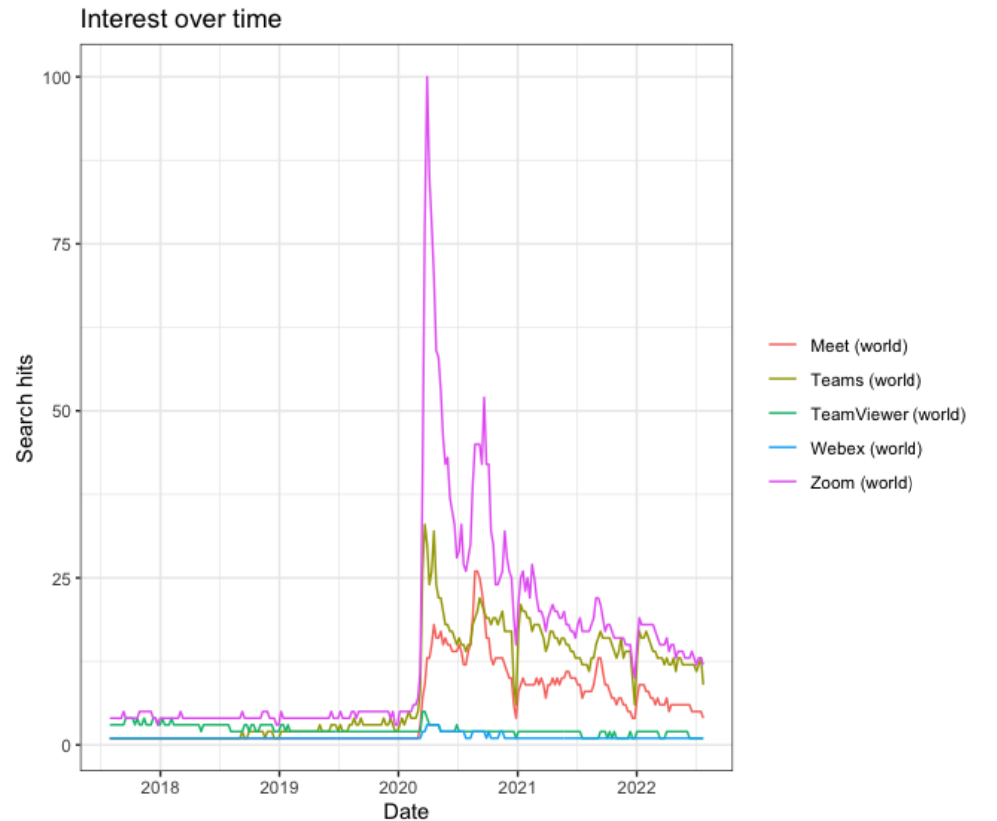
Figure 1. GT query for web and videoconferencing solutions (SaaS programs) (2017–2022); Created with the ggplot2 package in R environment with GT data sourced with the gtrendsR package.